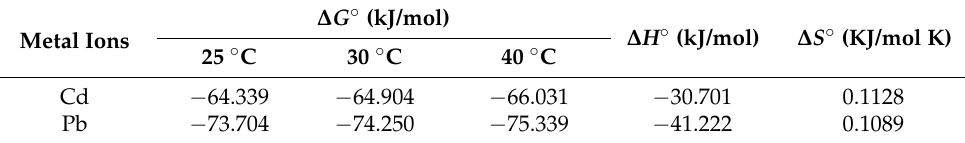
Figure 12. Van’t Hoff’s equation model for ( a ) Cd, and ( b ) Pb. Table 5. Thermodynamic parameters for Pb and Cd adsorption on FeNP/NFC.